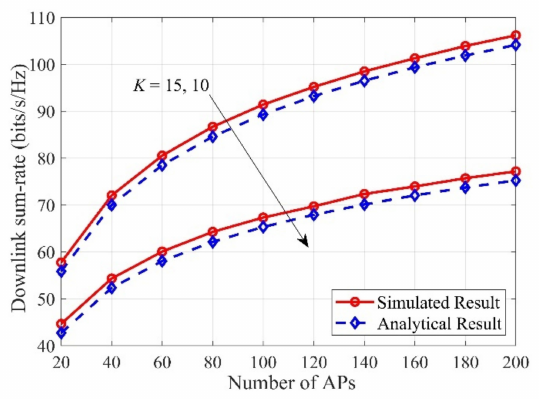
Figure 1. Downlink sum-rate versus the number of access points (Aps) with different numbers of users, with M = 60, N =